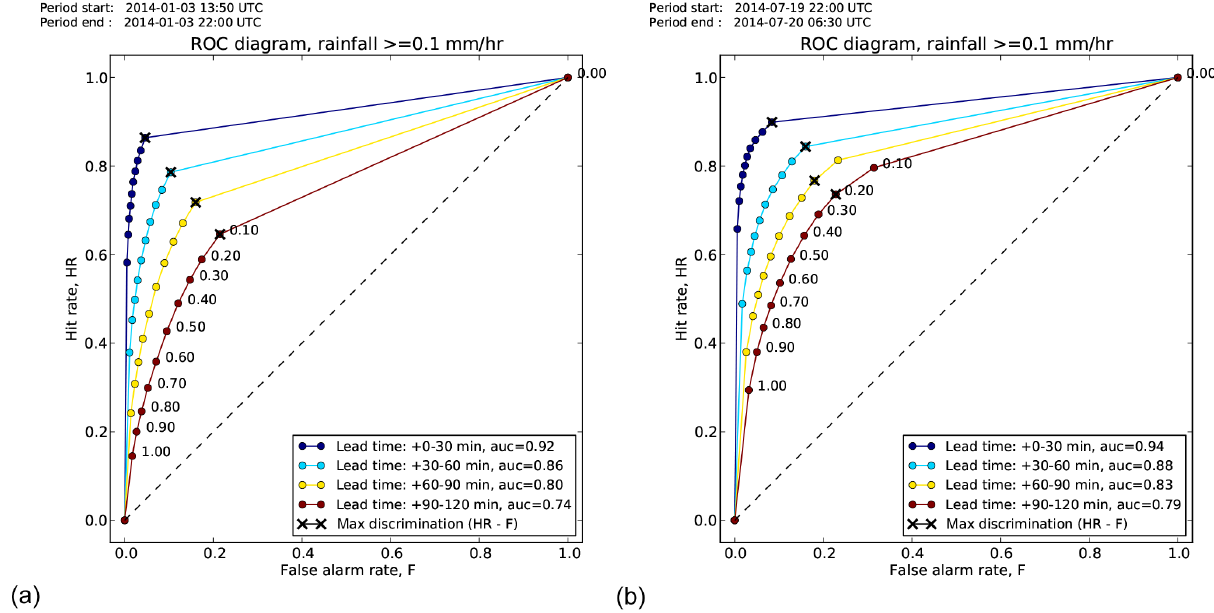
Figure 8. ROC curves relative to the probabilistic forecast of exceeding 0.1mmh − 1 for (a) the Ghent case on 3 January 2014 and (b) the Leuven case on 19–20 July